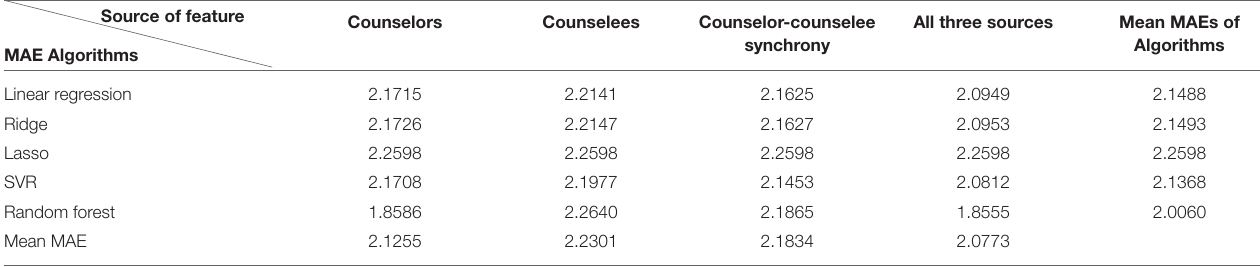
TABLE 1 | Performance of different algorithms and features sets in the model.